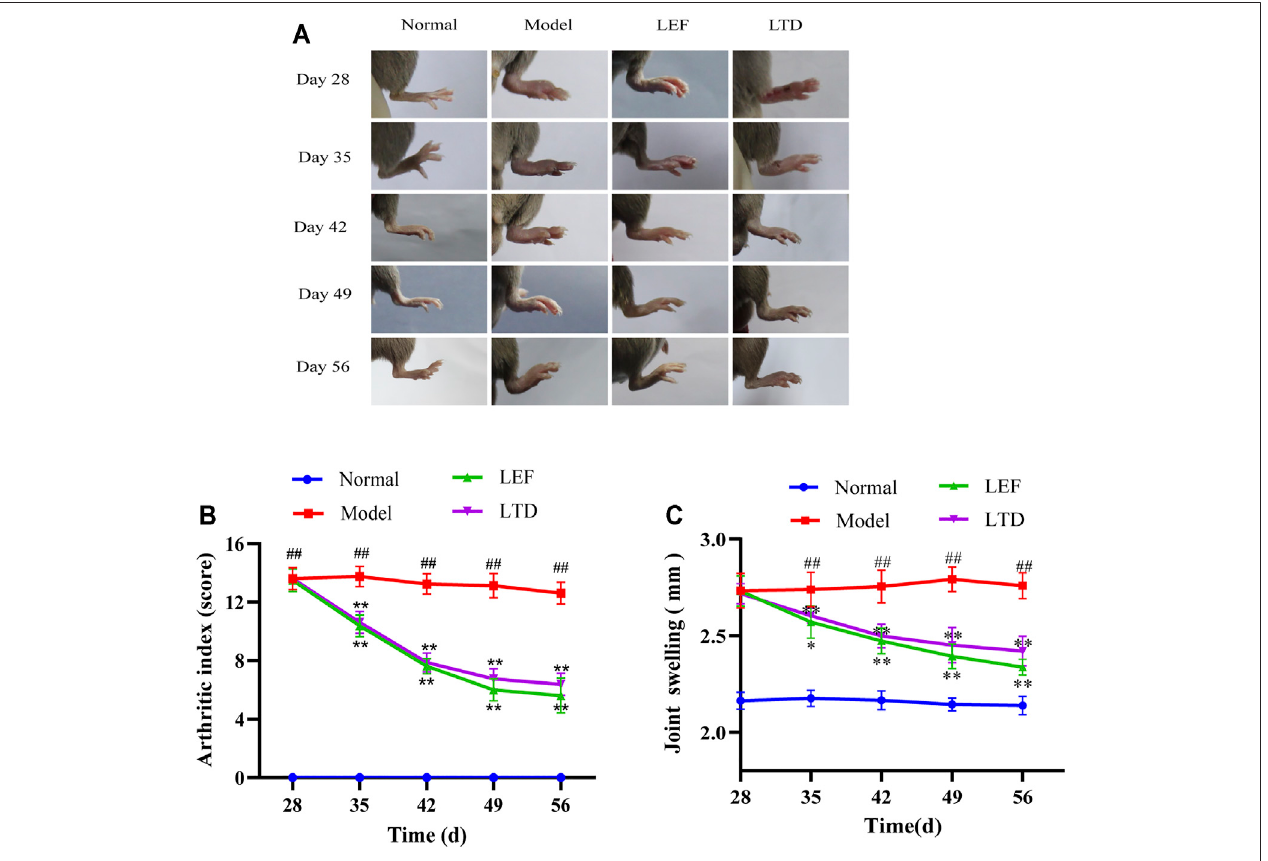
FIGURE 2 | LTD reduced the severity of joint swelling in CIA mice. (A) Changes in joint swelling in CIA mice. (B) Arthritis index score. (C) Changes in thickness of plantarjointinCIAmice.Alldataareshownasmeans ± S.D.( n (cid:1) 8);## p < 0.01,comparedwiththenormalgroup;* p < 0.05,** p <